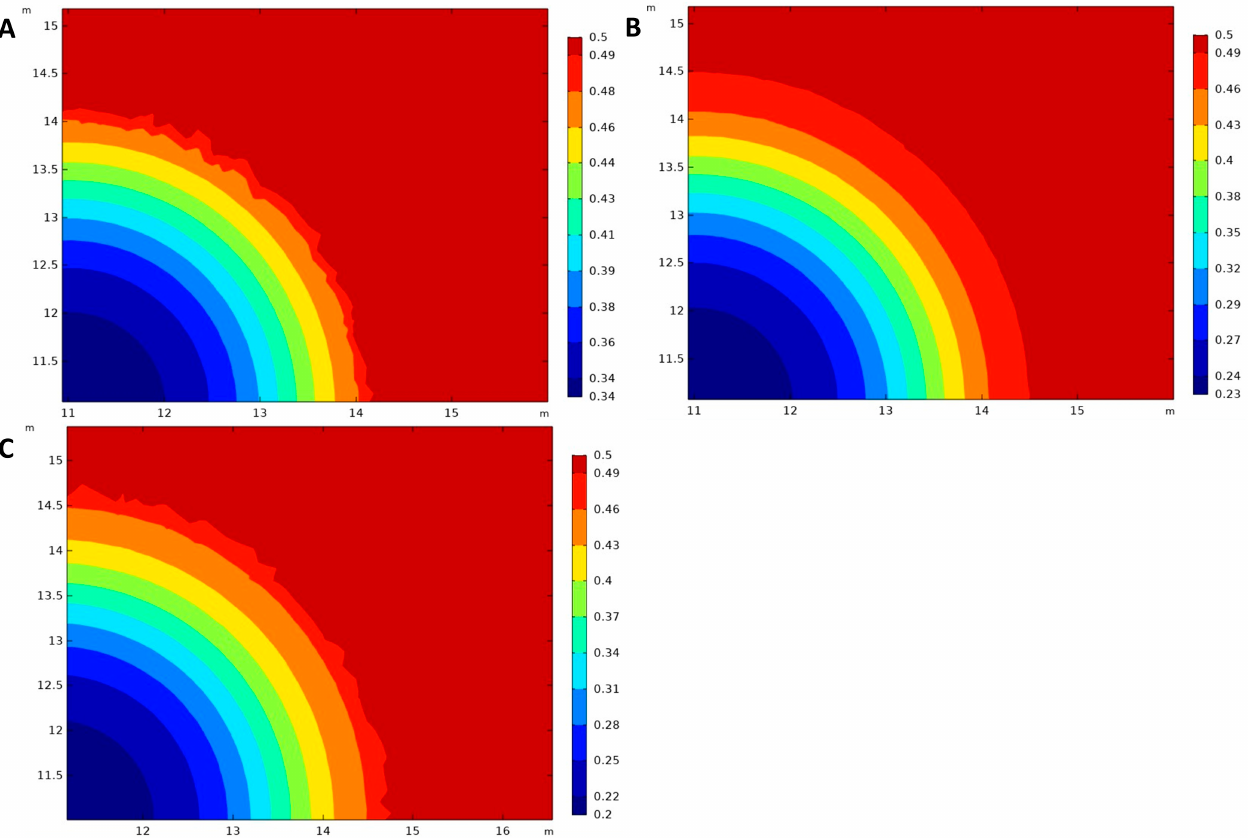
Figure 11. Cross-section of the surrounding rock near the selected orifice.